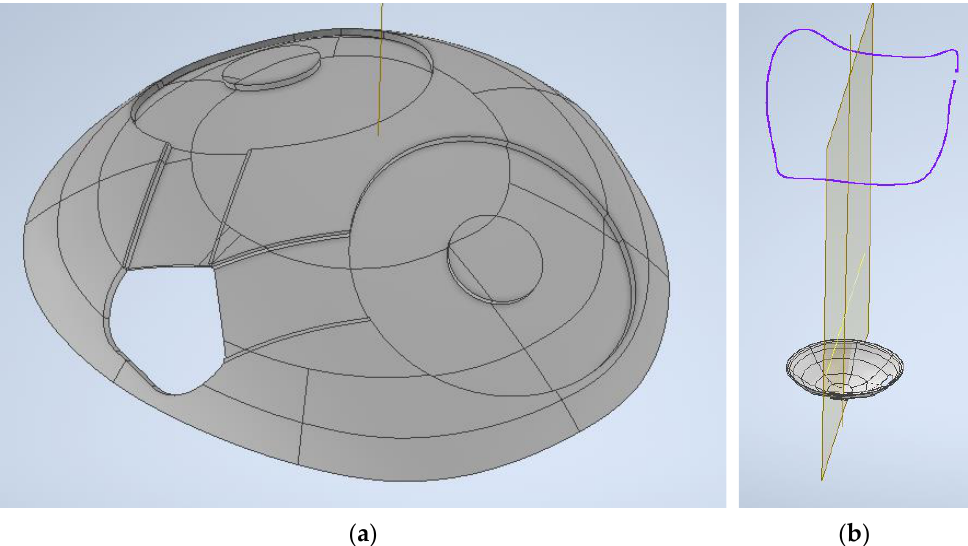
Figure 1. Digital model of the insert and a means to align the insert with the brimline. ( a ) Bottom view of the insert showing recesses for the antennae and antenna tails. The hole at the bottom left allowed the leadwires to bend 90° and pass through a hole in the socket wall (not shown). ( b ) The proximal brimline (purple) was scanned, and a reference mark in the sagittal plane (sagittal plane outlined in orange) was made on the insert to facilitate proper alignment during placement into the socket.